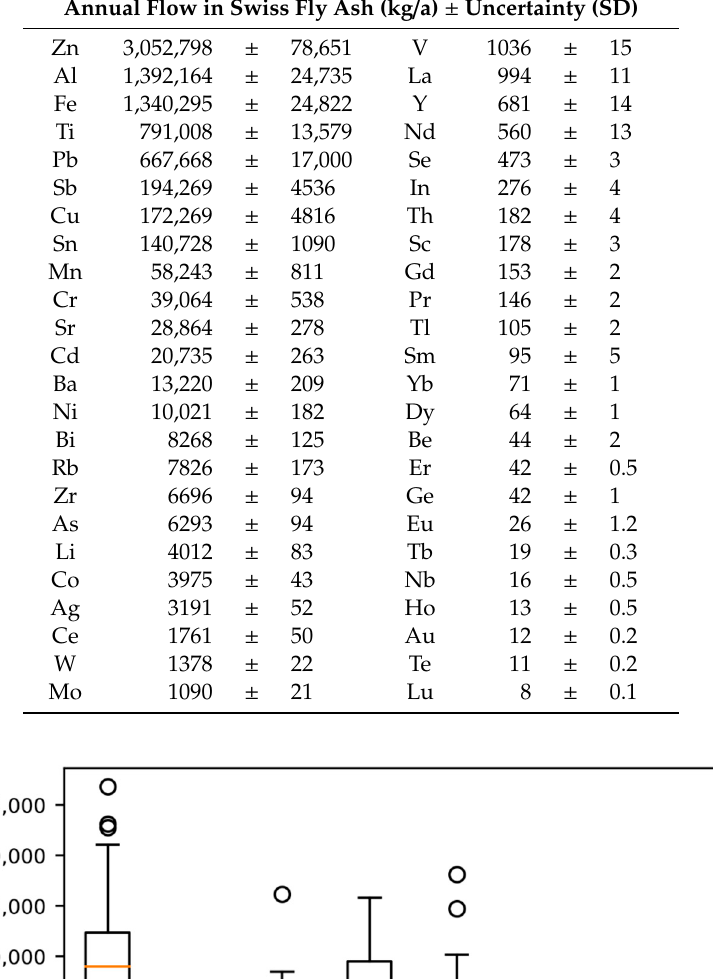
Table 3. Approximate annual flow of metals in Swiss FA.